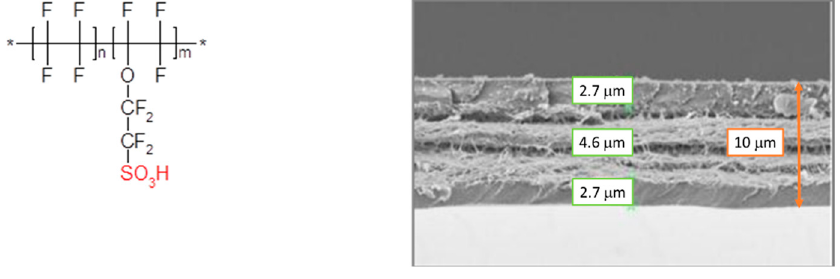
Figure 3. Chemical structure of Aquivion ® PFSA ( left ) and SEM images of cross-section of the Aquivion ® R79-01SX + membrane ( right ).